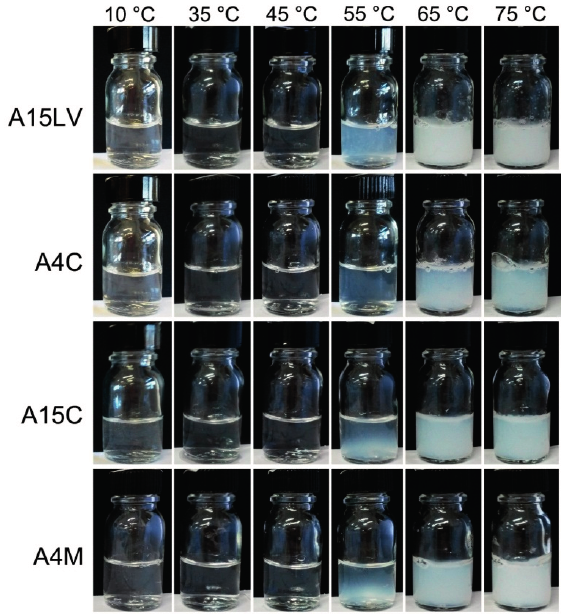
Figure 4. Influence of temperature and MW for 10 g/L aqueous solutions observed between 10 and 75